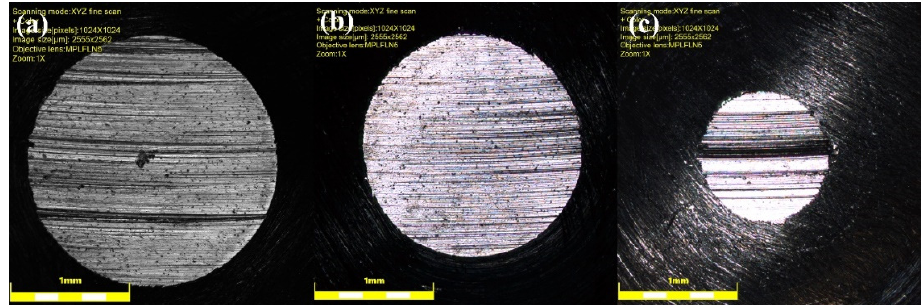
Figure 9. Wear-scar diameter of pins at 15 N for samples tested with ( a ) neat oil, ( b ) 0.10 vol.% nanolubricant, and ( c ) 0.30 vol.% nanolubricant.